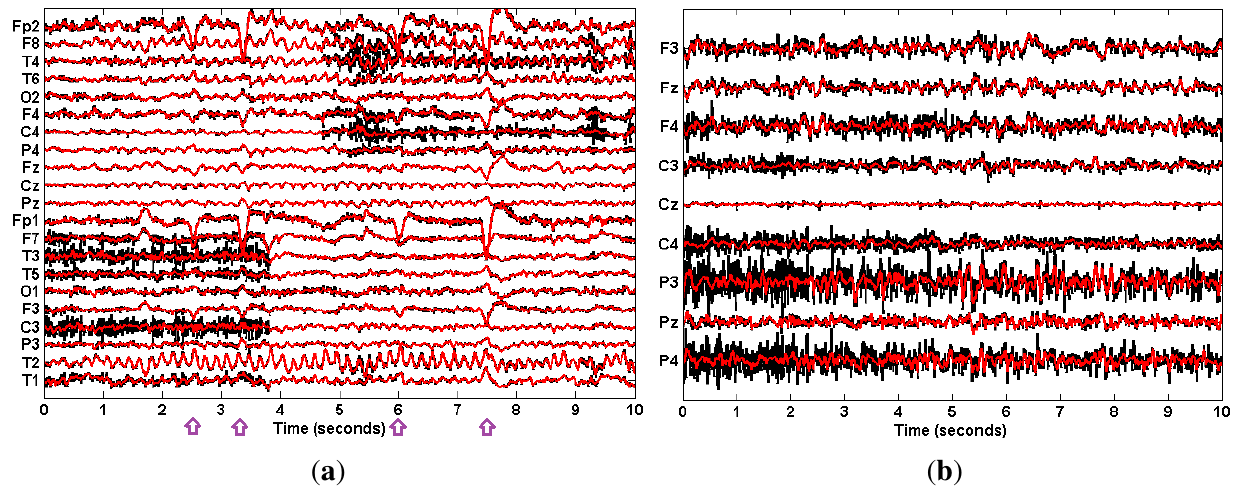
Figure 8. The reconstructed EEG signals after muscular artifact cancellation (red) compared with the original EEG recordings (black): ( a ) ictal; ( b ) cycling. The purple arrows indicate EOG events.